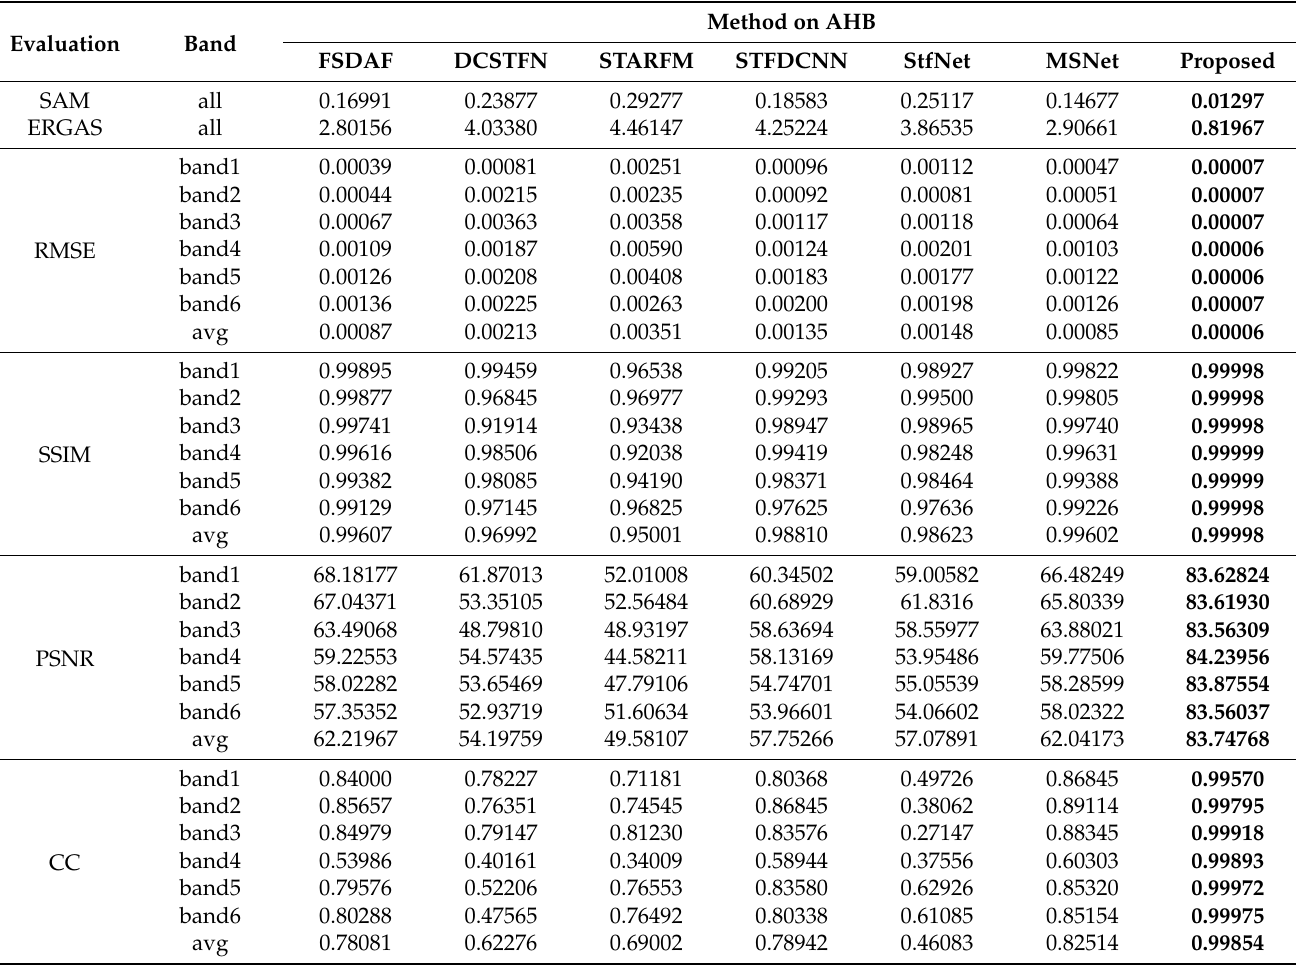
Table 3. Quantitative assessment of various spatiotemporal fusion methods for AHB